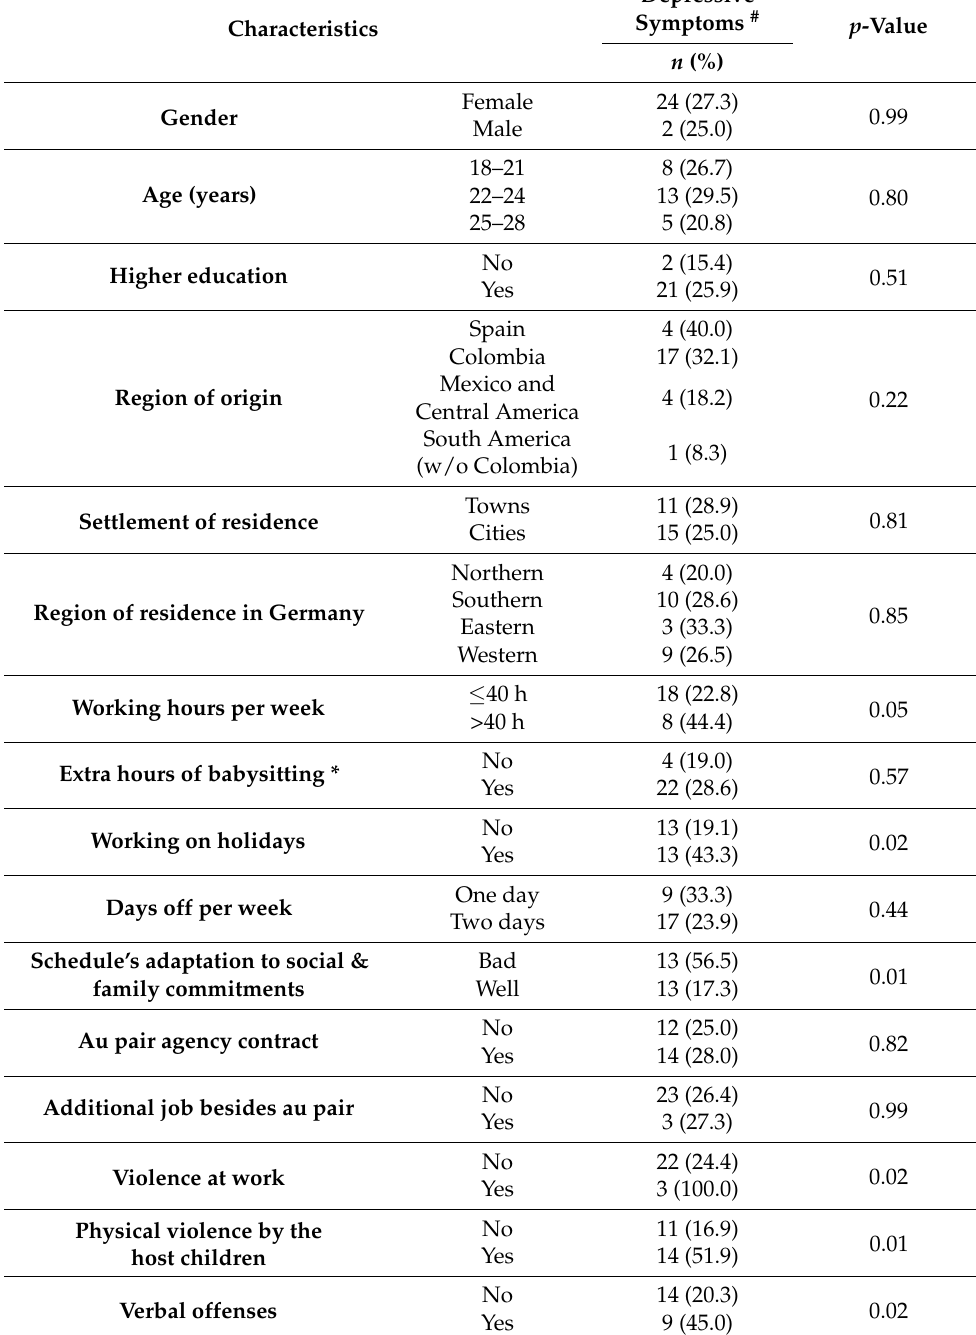
Table 2. Prevalence of Depressive Symptoms (PHQ-9) among Spanish-speaking au pairs living in Germany at T2 = 6-month follow-up (N = 99) by potential risk